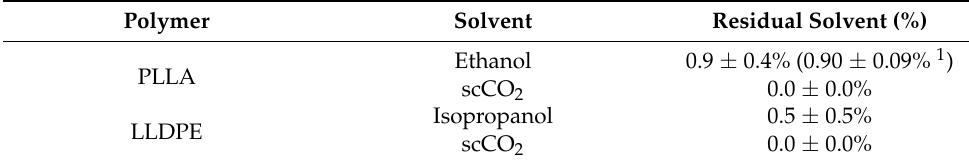
Table 3. Residual Solvent.